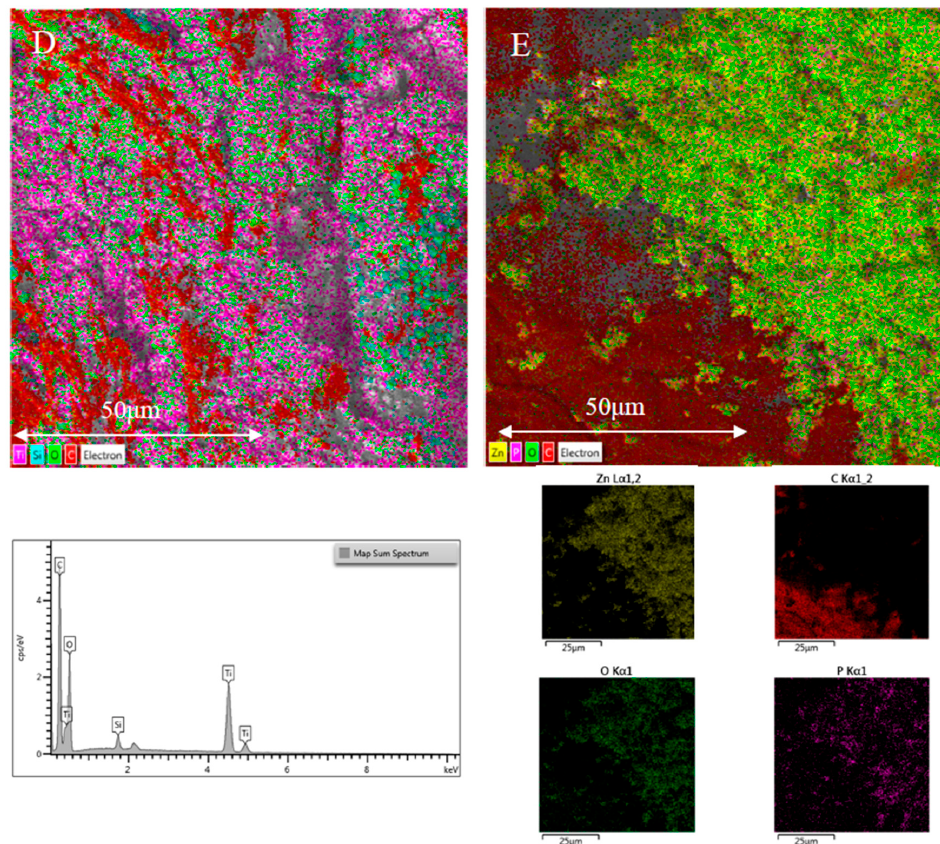
Figure 3. SEM micrographs taken with a working distance (WD) of 9.12 mm, accelerating voltage for electrons (HV) of 10 kV, and backscattering electron detector (BSE) of ( A ) AC, ( B ) AC–TiO 2 , and ( C ) AC–ZnO. EDS mapping and sum spectrum of ( D ) AC–TiO 2 and ( E )